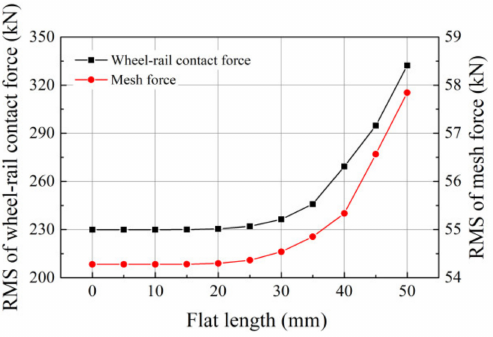
Figure 11. Variation of RMS of excitations versus the flat length.